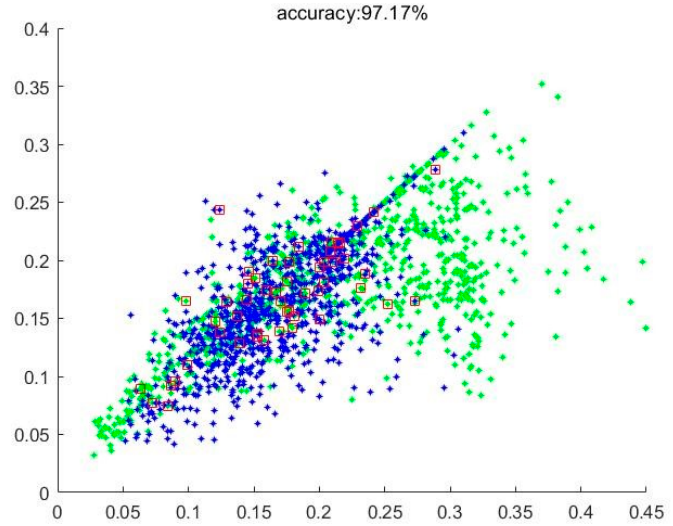
Figure 8. Scatter plot of test results using RotLBP and gray level-gradient co-occurrence matrix (GGCM) fusion features.